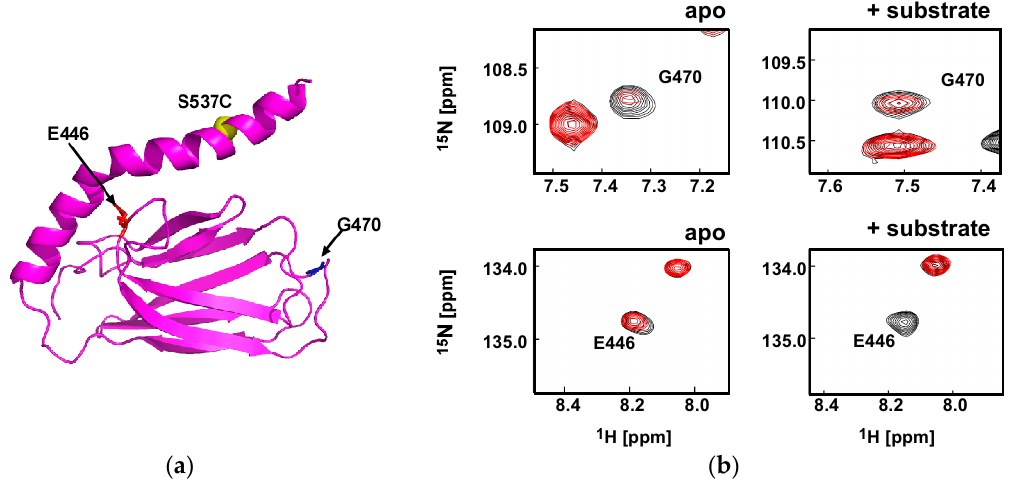
Figure 6. PRE experiments with SBD( ∆ CDE)-y with spin labeling at residue 537. ( a ) The spin-labeling position in the solution structure of SBD( ∆ CDE)-y is shown, in which, S537 was exchanged to cysteine to facilitate covalent labeling with MTSL; ( b ) Representative spectral changes caused by the paramagnetic effect. In the left two panels, 2D 1 H- 15 N HSQC spectra are overlaid for the paramagnetic spin labeled sample (red) and for the sample with a diamagnetic label (black) in the absence of the NR-peptide. In the two panels on the right, the corresponding spectral comparison in the presence of 5.0 mM NR-peptide. The concentration of SBD( ∆ CDE)-y was adjusted to 0.5 mM.